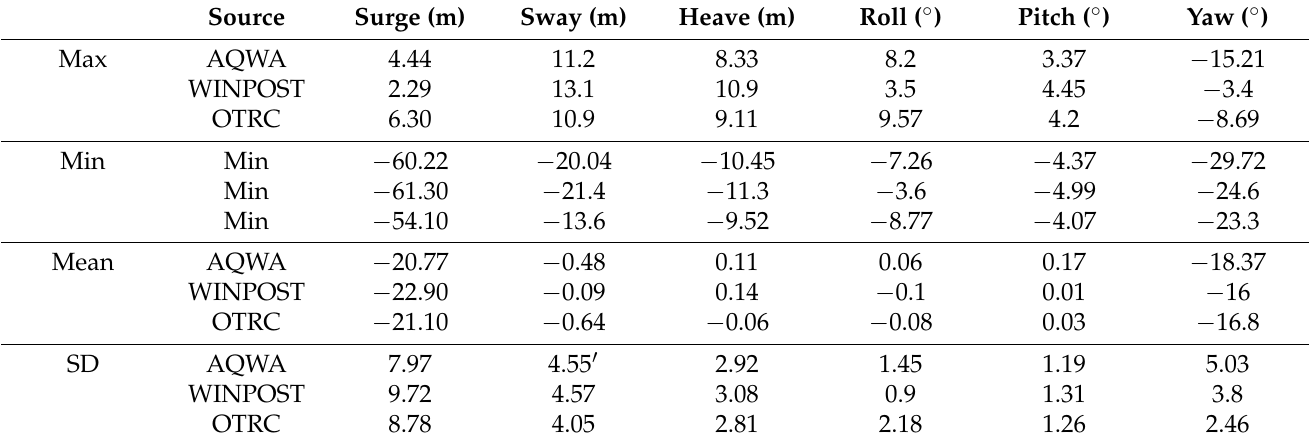
Table 8. Statistical comparison of hydrodynamic responses in 6